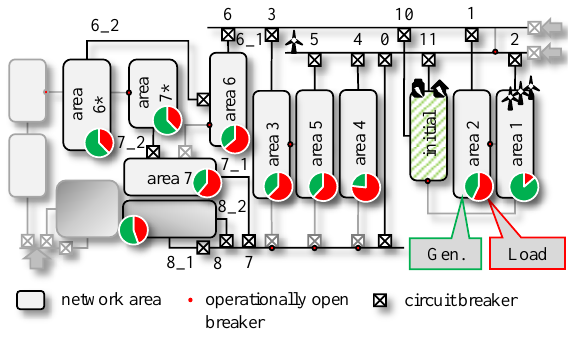
Fig. 2. Schematic plan of the SWW medium voltage grid SWW's distribution network has a high penetration of renewable energies. A significant part of the installed generation capacity is located in the city centre of Wunsiedel (area 3-5) and the urban areas of 1-2 and 7 (see Fig. 2 ). Notably, this includes a 13.5 MW combined heat and power (CHP) plant and an 8 MVA battery energy storage system (BESS) displayed with initial. Additionally, a 1.2 MW black start capable CHP plant